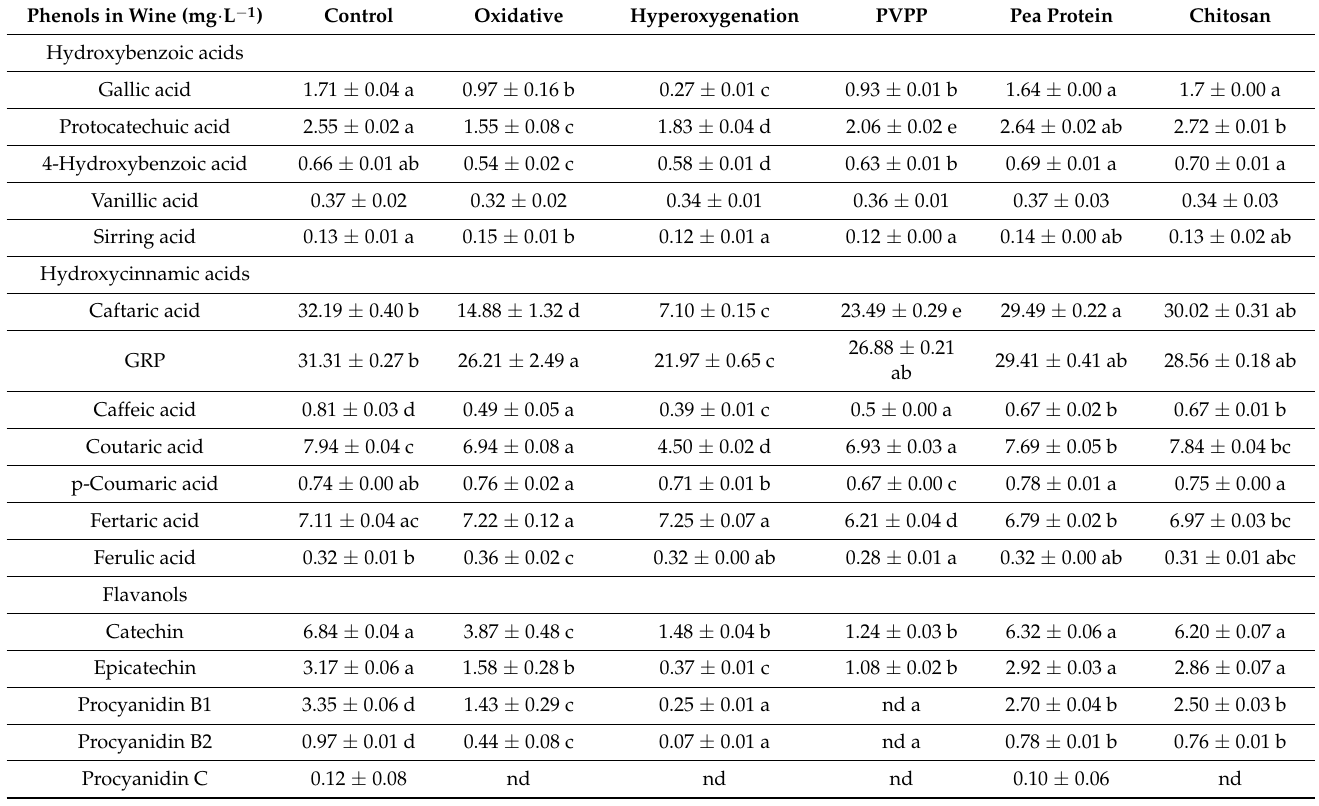
Table 3. Mean value of concentration of selected phenolic compounds in wines (mg · L − 1